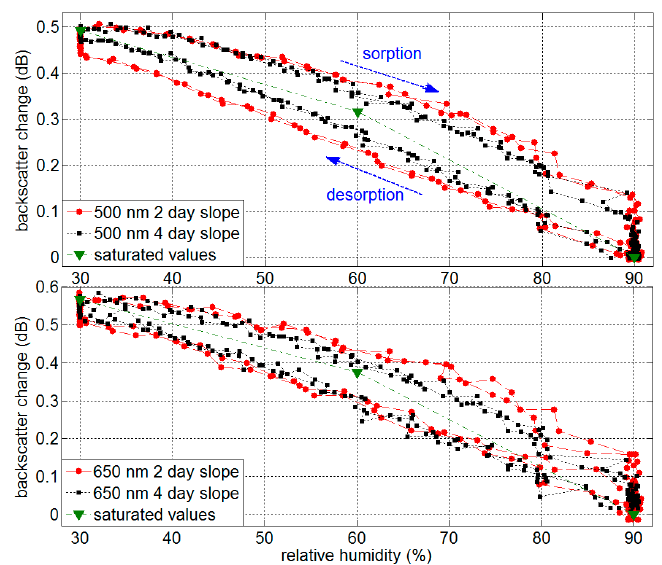
Figure 7. Backscatter change during linear RH changes (2-day and 4-day slope for two full cycles) and saturated RH values at 500 nm and 650 nm (the sorption/desorption deviation is due to the response time of the backscatter change effect).